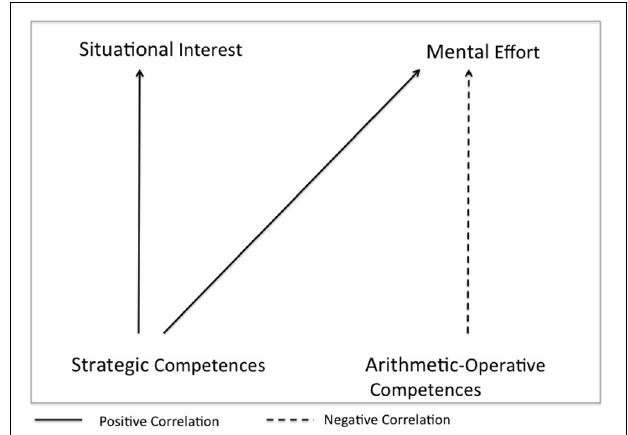
FIGURE 1 | Hypothetical correlations between arithmetic-operative competences, strategic competences, situational interest, and mental effort with a focus on the facilitating function and enabling function (Sweller et al., 1998; Sweller, 1999; Schnotz and Rasch,